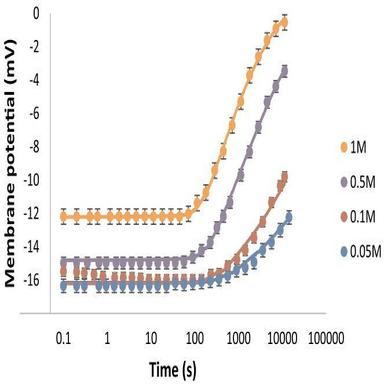
Time evolution of trans-membrane potential for various base concentrations, C0, for Nafion 120. Cstep is always two times higher than C0. Symbols represent experimental data and solid lines are the theoretical fits.